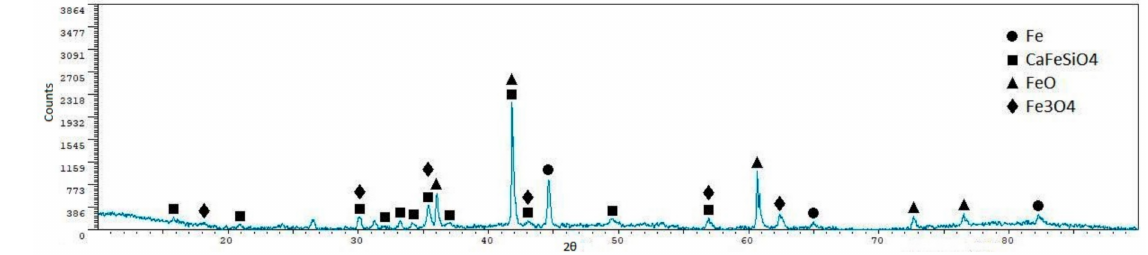
Figure 20. X-ray diffraction pattern for the sample BF2.